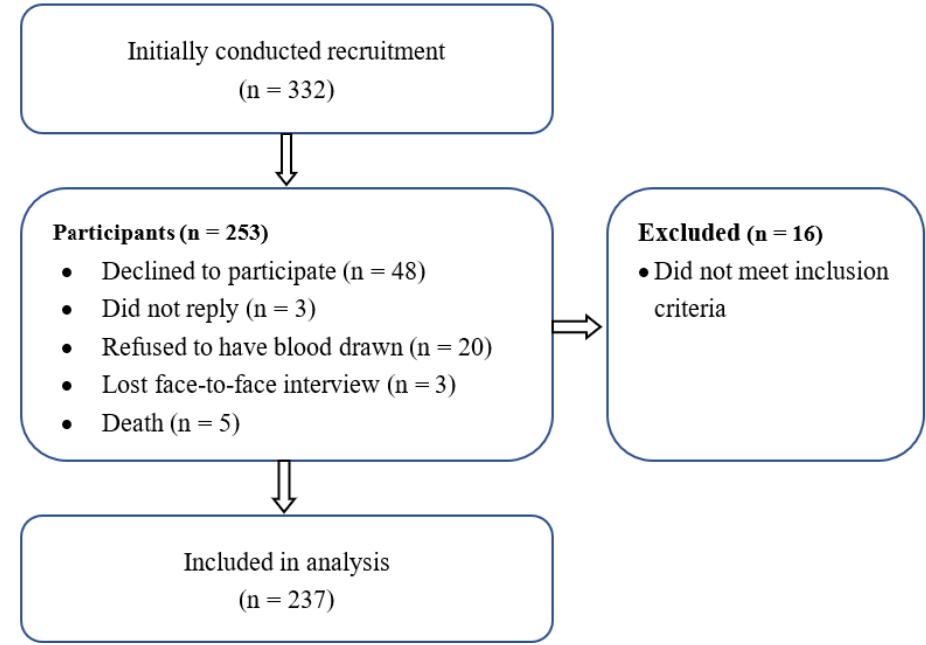
Figure 1. Consort diagram of the cross-sectional study.